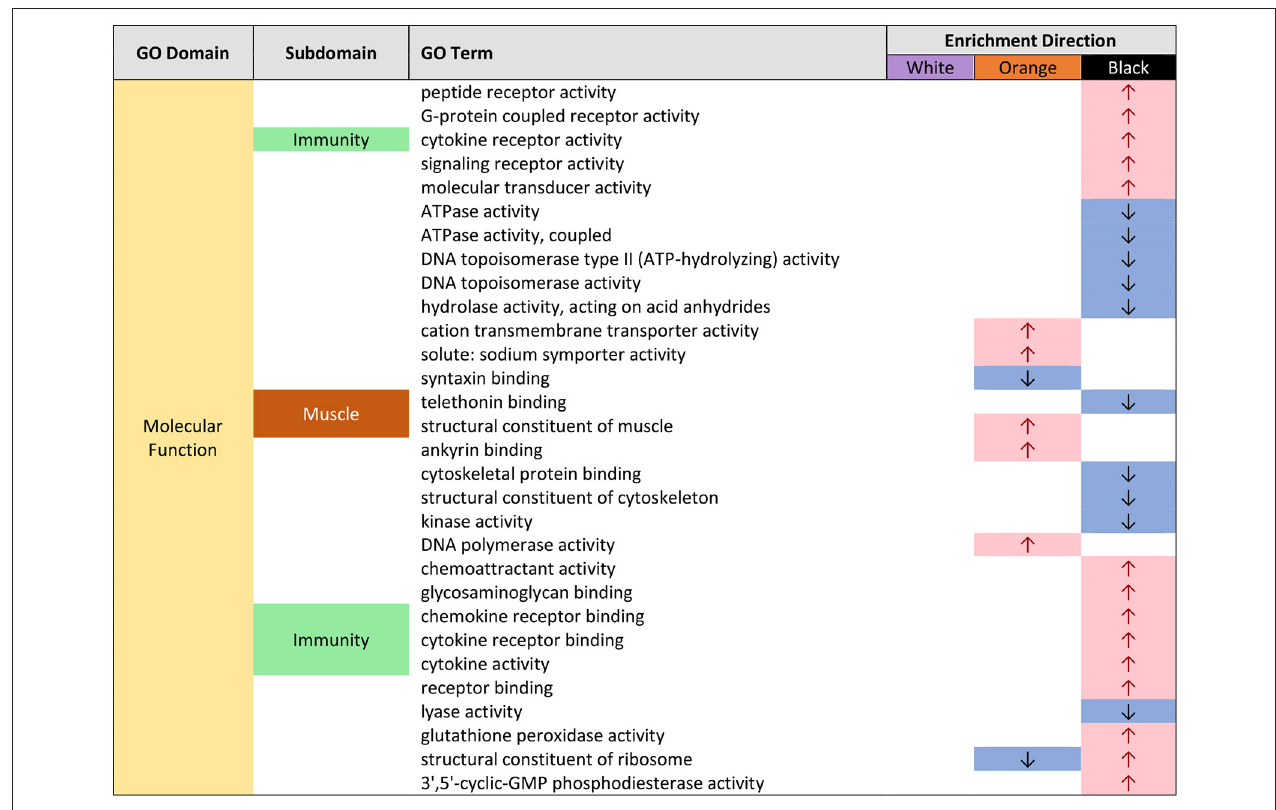
FIGURE 4 | Gene ontology (GO) categories significantly enriched for both pairwise color comparisons for each epidermal tissue by “molecular function” (MF) using Mann-Whitney U tests based on ranking of signed log p -values computed using EdgeR . Results indicate the GO domain (MF), the subdomains discussed in text (“immunity” and “muscle”), the specific GO terms, and enrichment direction observed consistently in each epidermal tissue